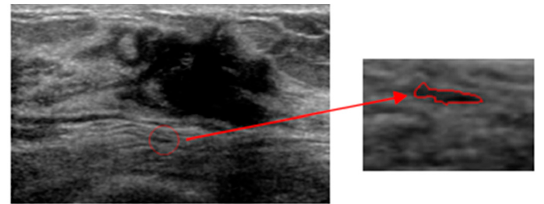
Figure 4. Input image of SLIC network.